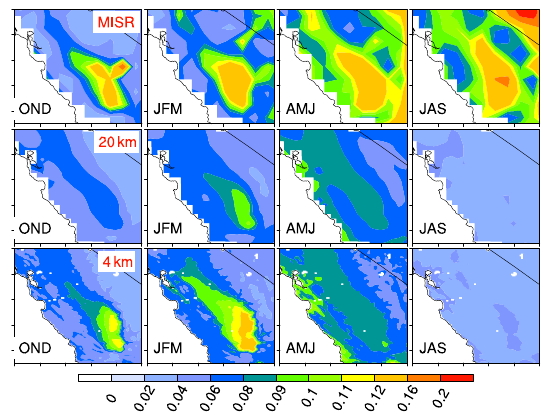
Figure 3. Spatial distribution of seasonal mean 550nm AOD from MISR and the WRF-Chem (20km and 4km) simulations in WY2013. OND: October–November–December; JFM: January– September.